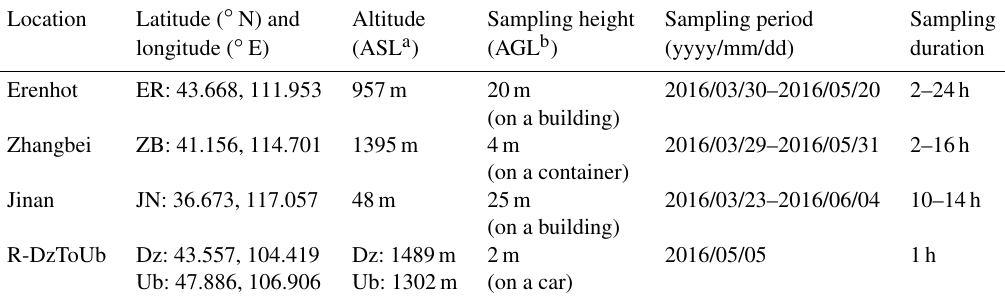
Table 1. Information on the sampling sites. Location Latitude ( ◦ N) and Altitude Sampling height Sampling period